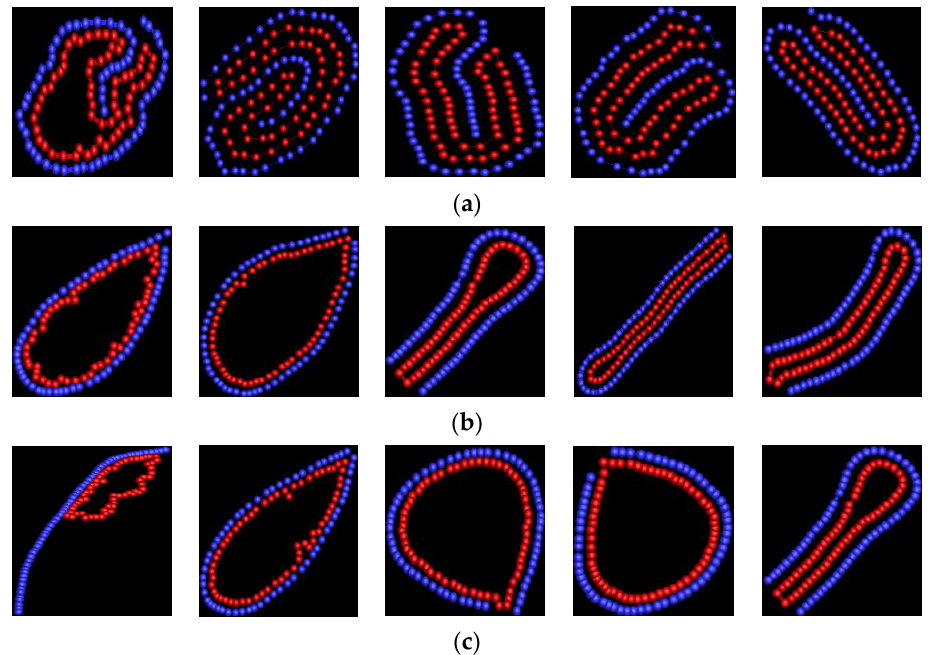
Figure 5. The snapshot of linear semiflexible polymer/ring polymer composites. The blue one represents the linear polymer, and the red one represents vesicle. The VP of snapshots is 2, 4, 6, 8, and 12 from left to right for ( a ) κ = 10, ( b ) κ = 150, and ( c ) κ = 300.